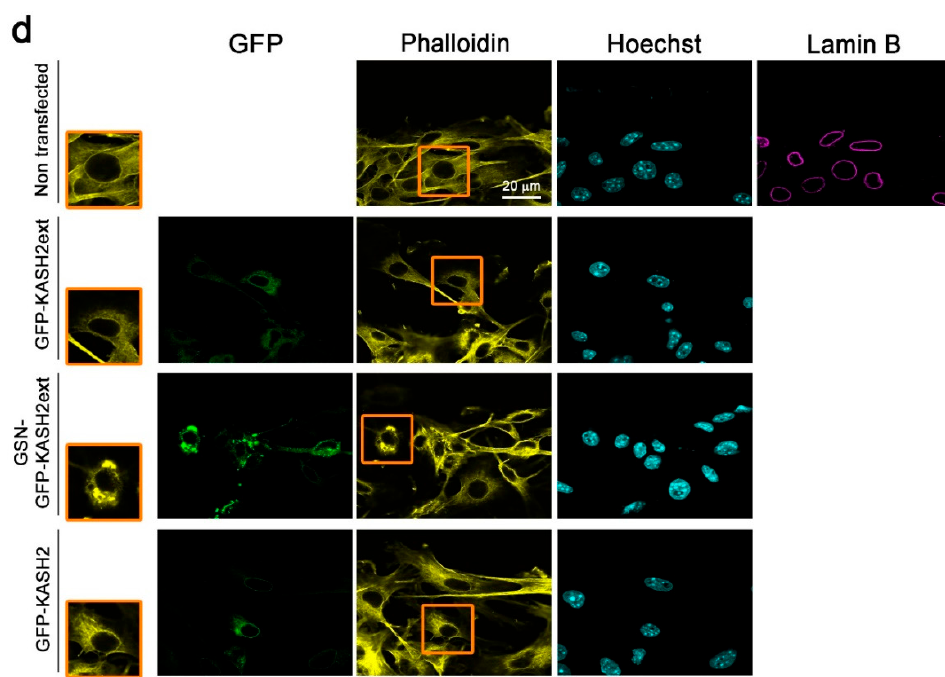
Figure 4. Interference with the perinuclear actin rim by perinuclear-localized Gelsolin (GSN) ( a ) Fluorescence microscope micrographs of confluent B16–F10 cells either non-transfected or expressing GFP-KASH2ext, GSN-GFP-KASH2ext, or GFP-KASH2 induced to migrate in the wound healing assay for 3 h stained for filamentous actin (Phalloidin) and DNA (Hoechst). Lamin B1 was immunostained. The edge of the scratch is in the top region of each micrograph. The nuclei in the orange rectangles are magnified on the left side. Scale bar: 20 µ m. ( b ) Quantification of the e ff ect of GFP-KASH2ext, GSN-GFP-KASH2ext, and GFP-KASH2 on perinuclear actin filaments. In each experiment, 20–30 cells of each transfection were measured for the Phalloidin signal at the nuclear periphery. The average mean intensity was calculated and normalized to non-transfected cells. The average mean intensity in three independent experiments ± s.e. is presented. Statistical significance was evaluated by the Student’s t -test, * p < 0.05. ( c ) Quantification of the e ff ect of GFP-KASH2ext, GSN-GFP-KASH2ext, and GFP-KASH2 on the total amount of actin filaments. In each experiment, 20–30 cells of each transfection were measured for the mean Phalloidin signal in the whole cell. The average mean intensity was calculated and normalized to non- transfected cells. The average mean intensity in three independent experiments ± s.e. is presented. Di ff erences between samples were not significant statistically by the Student’s t -test ( d ) Laser scanning microscope micrographs of non-transfected and transfected B16–F10 cells as in